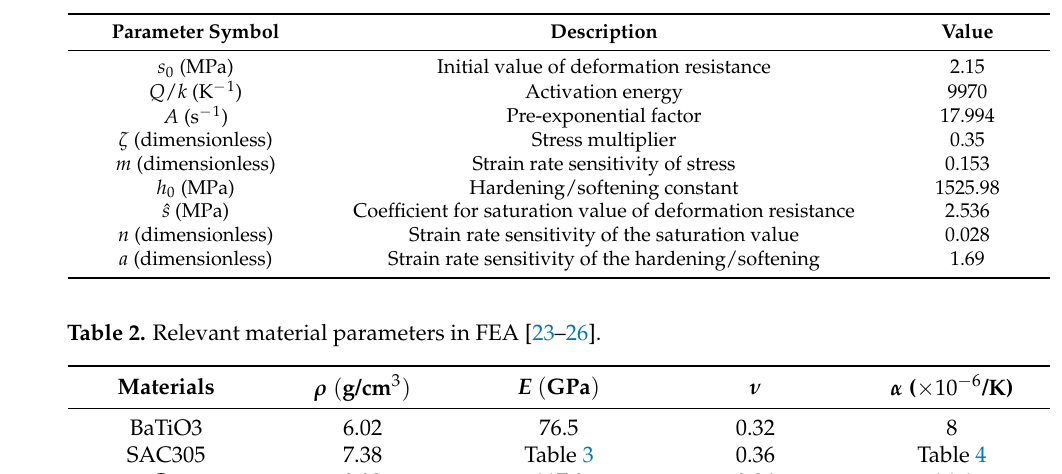
Table 1. Anand model parameters for SAC305 [22].